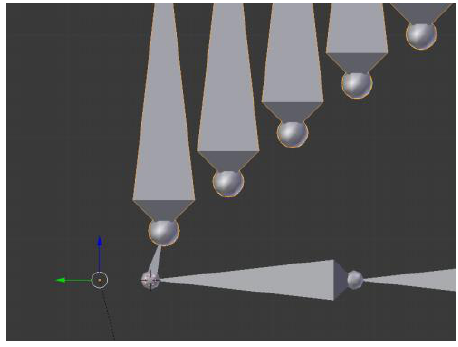
Figure 4. Visualisation of the Amplifier object.